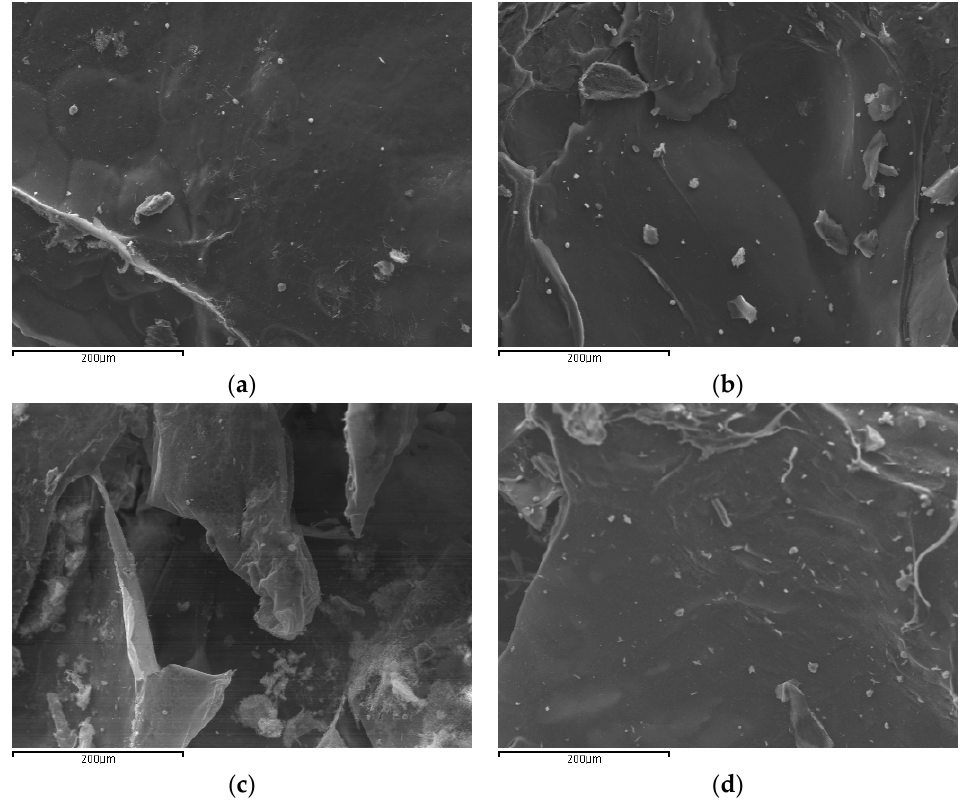
Figure 6. SEM images of the synthesized adsorbents: ( a ) CsSUC; ( b ) CsMAL; ( c ) CsITA; ( d )